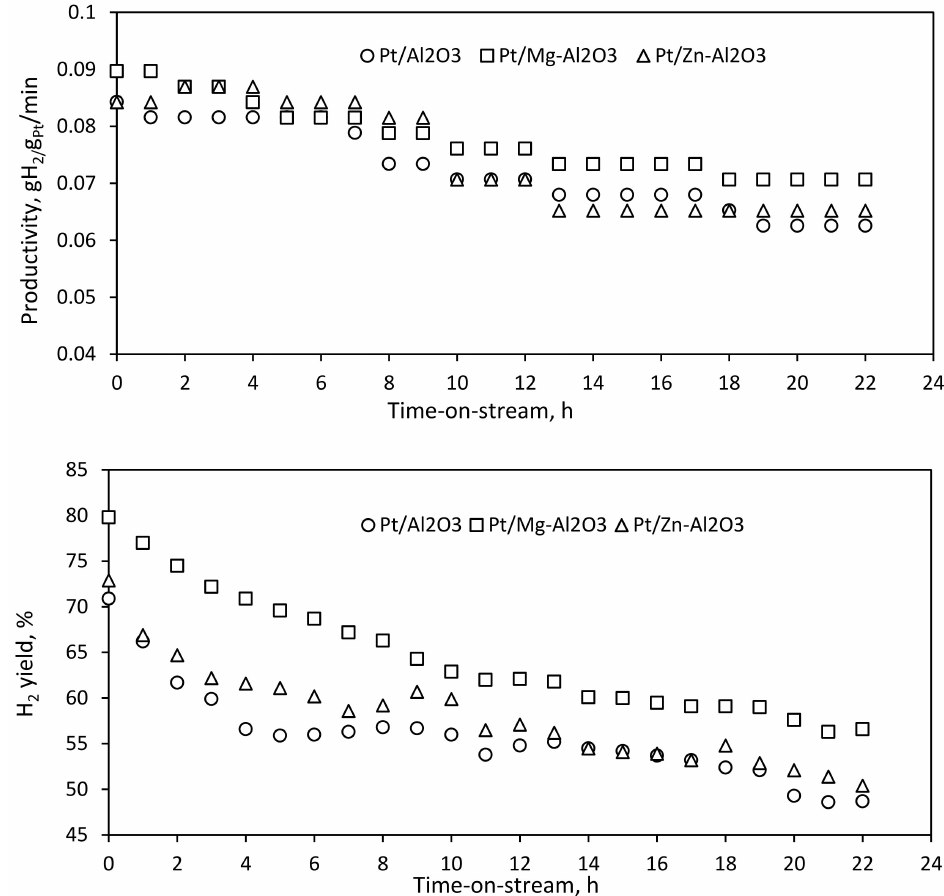
Figure 2. Catalyst productivity and hydrogen yield vs. time-on-stream for dehydrogenation of H18- DBT over 22 h. Reaction parameters: Pt loading 0.5 wt.%, H18-DBT doh 99.6%, reaction temperature